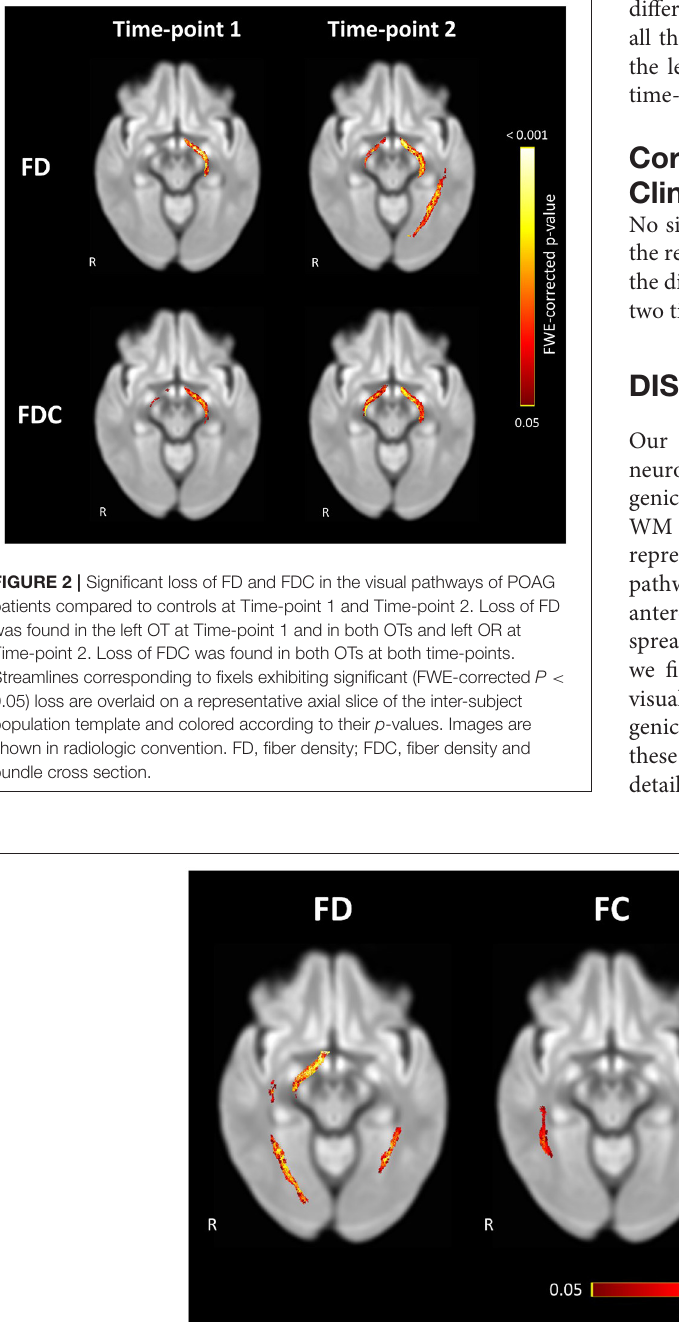
Frontiers in Human Neuroscience |